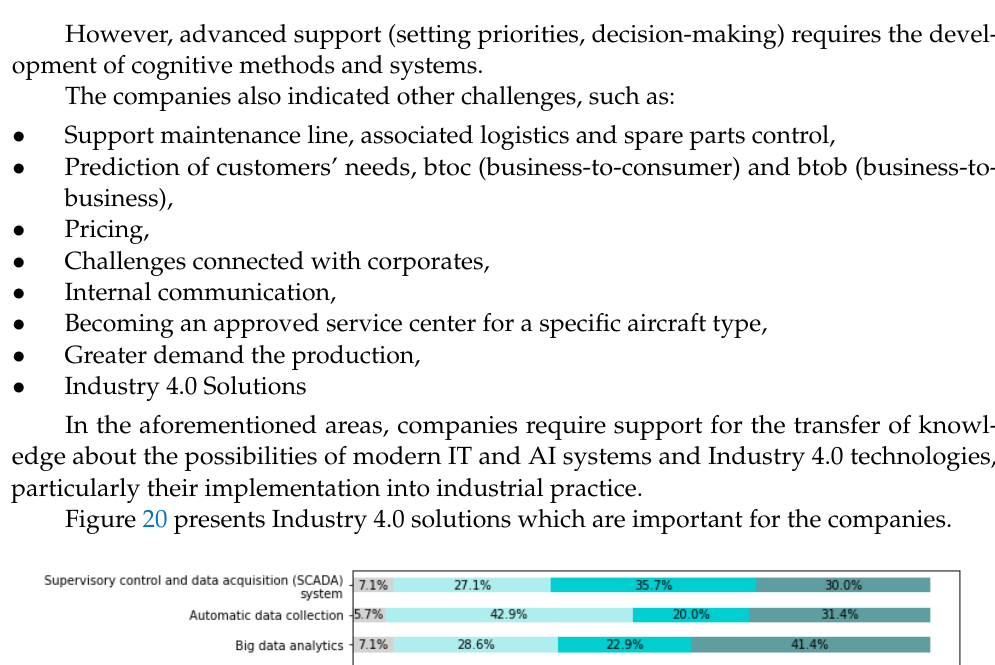
Figure 19. Challenges related to manufacturing process monitoring and improvement — number of questionnaires in a total number of 70 questionnaires.